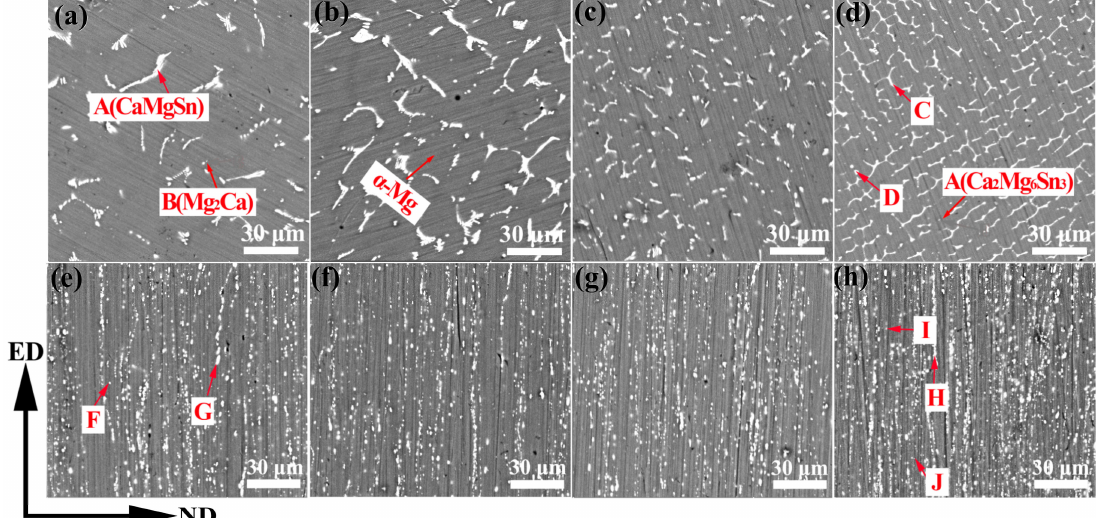
Figure 1. SEM images of the as-homogenized ( a – d ) and as-extruded ( e – h ) Mg-1.0Sn-0.5Ca-xZn alloys: ( a , e ) TX10 alloy; ( b , f ) TXZ100 alloy; ( c , g ) TXZ101 alloy; ( d , h ) TXZ102